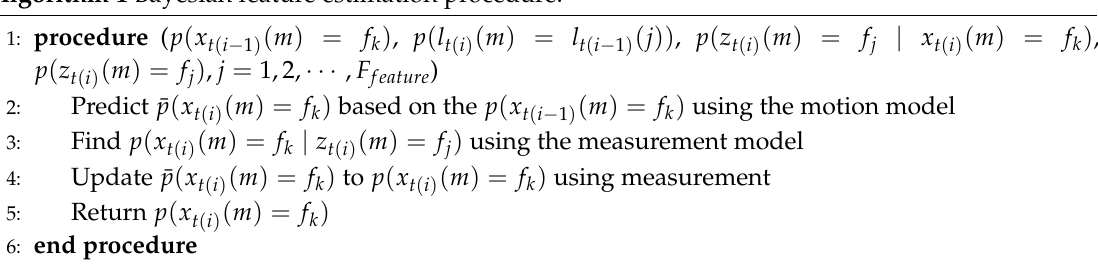
Algorithm 1 Bayesian feature estimation